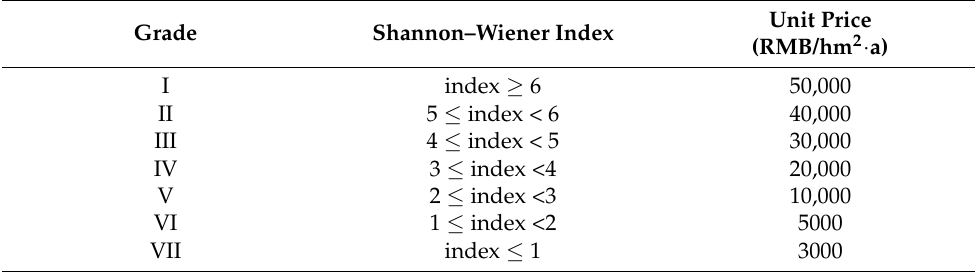
Table 9. Shannon–Wiener index grade and corresponding